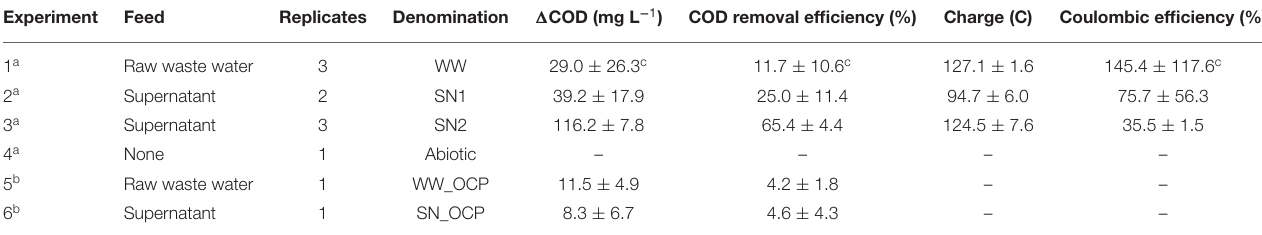
FIGURE 1 | Chronoamperometric current densities of bioelectrochemical systems fed with different fractions of anaerobic digestion effluent treating hydrothermal carbonization process water polarized at + 0.397 V vs. SHE (30 ◦ C and 150rpm). With (A) untreated AD effluent (WW), (B) supernatant obtained from WW by physical precipitation for 48h at 4 ◦ C (SN1), (C) supernatant obtained by physical precipitation from WW for 48h at 4 ◦ C and after 40 days of storing (SN2). Green solid line: abiotic control. Black, blue, and red solid line: experimental replicates. TABLE 1 | List of performed potentiostatically controlled and open circuit potential (OCP) experiments with determined COD removal ( 1 COD), charge, and coulombic efficiency.